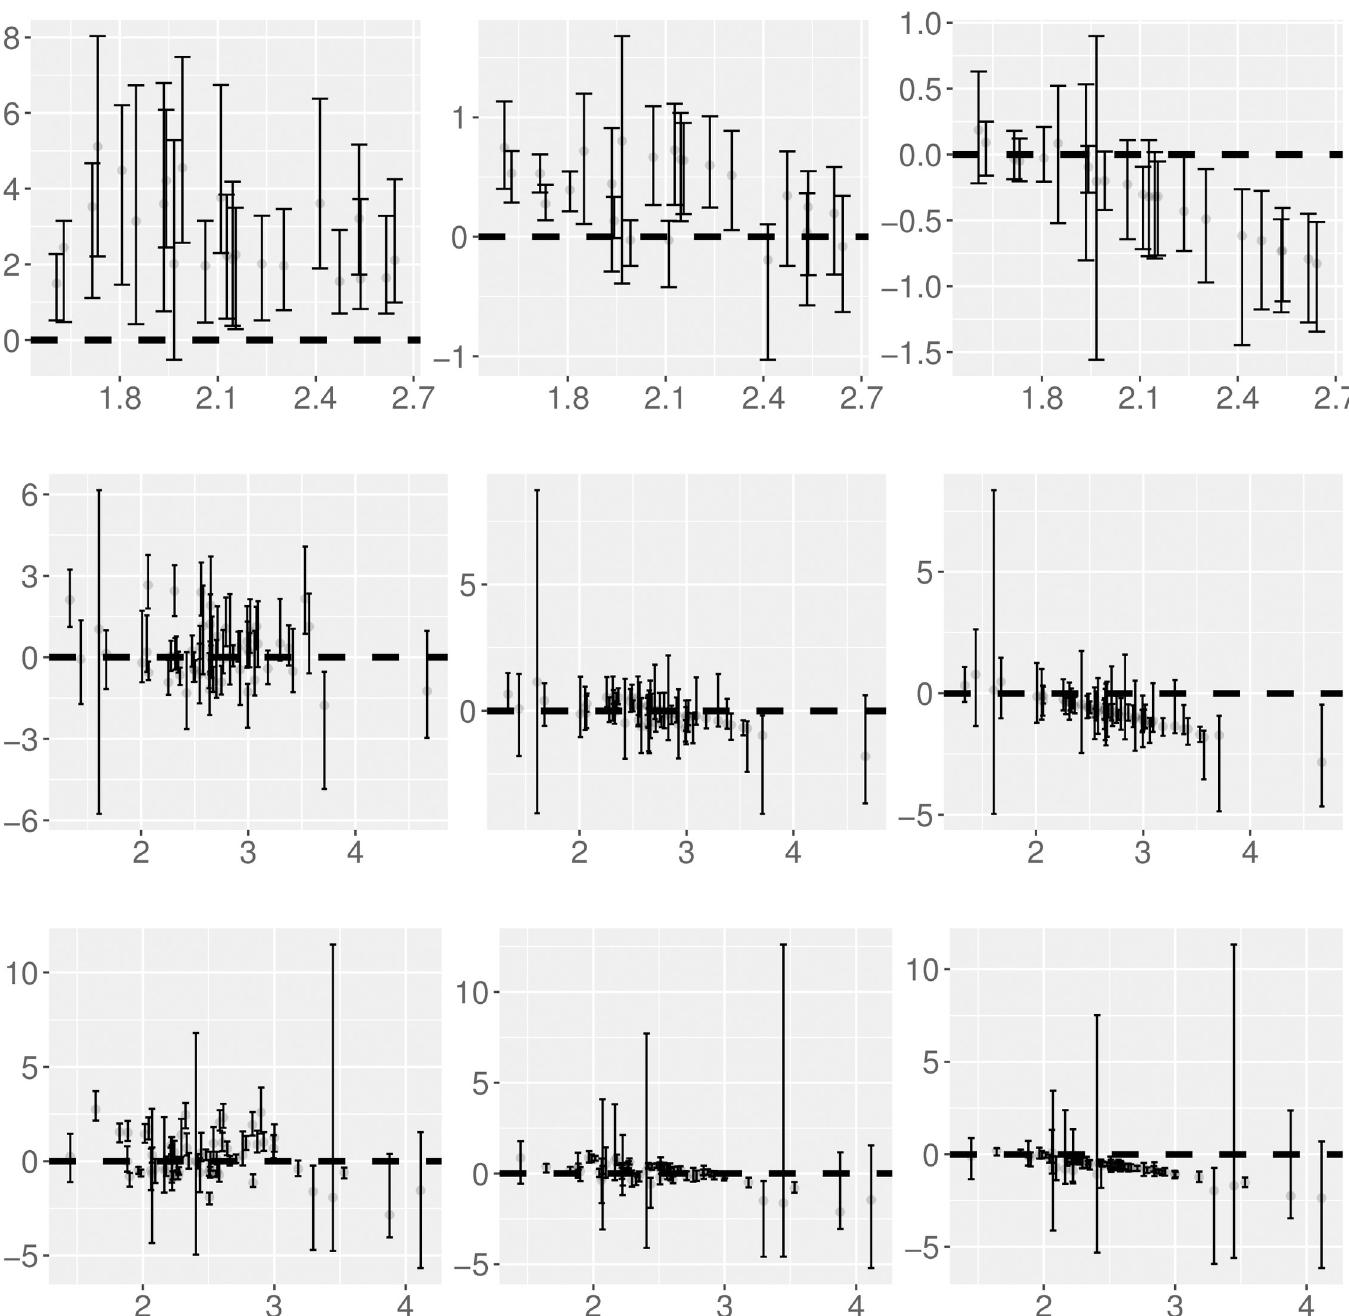
Fig 2. Difference of TL’s slope between each predictive model and the best linear regression model against TL’s slope estimate from the best linear regression model. The top, middle, and bottom rows correspond to spatial hierarchical TL, spatial TL, and temporal TL respectively. The left, middle, and right columns correspond to respectively the difference in slopes between the CX model and the best linear model, between the Tweedie model and the best linear model, and between the XLW model and the best linear model. Grey dots show the medians of the slope difference and error bars show the 95% interval estimates for each combination of TL, model, and census or state. The dashed horizonal line is the horizontal line at zero. An interval estimate above, across, or below the dashed line indicates that a model’s slope estimate is significantly higher, not significantly different, or significantly lower than the corresponding slope estimate from the best linear model.